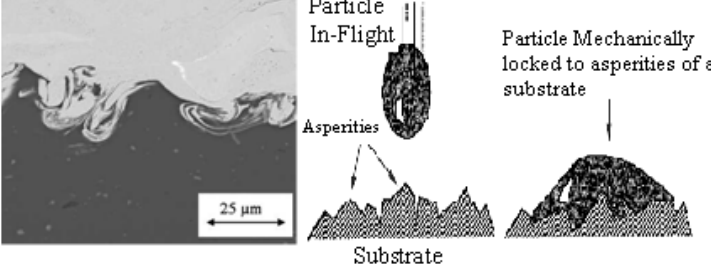
Figure 5: EDS image of Cu coating on Al [11] & Schematic of mechanical locking